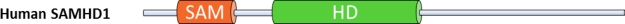
Schematic representation of the human SAMHD1 protein indicating the SAM and the HD domain. A putative feline SAMHD1-encoding gene is found on cat chromosome 13.